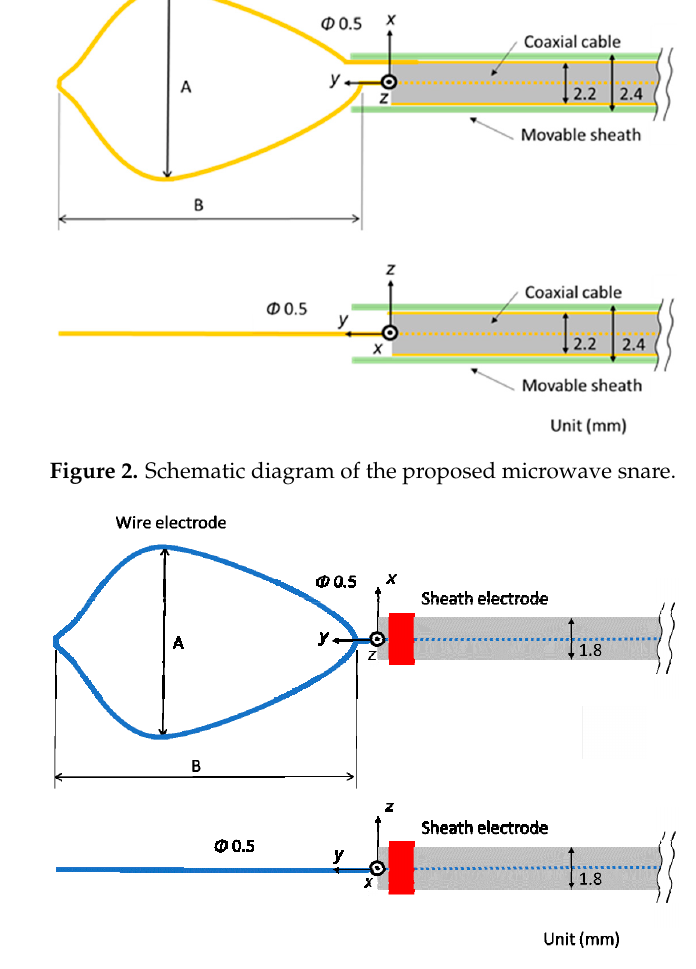
Figure 3. Schematic diagram of a commercially available snare.